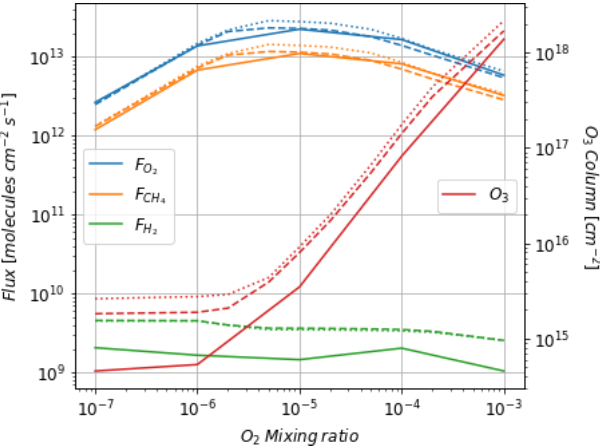
), methane atmospheric Figure 3. Oxygen atmospheric loss ( F O 2 ), hydrogen escape ( F H loss ( F CH ) and O 3 column density as a 2 4 function of surface O 2 for a surface CH 4 set up at 10 − 4 . Solid: results of the 3D model (averaged over the surface and a year). Dashed: 1D results at a zenith solar angle of 60 ◦ . Dotted: 1D re- sults at a zenith solar angle of 40 ◦